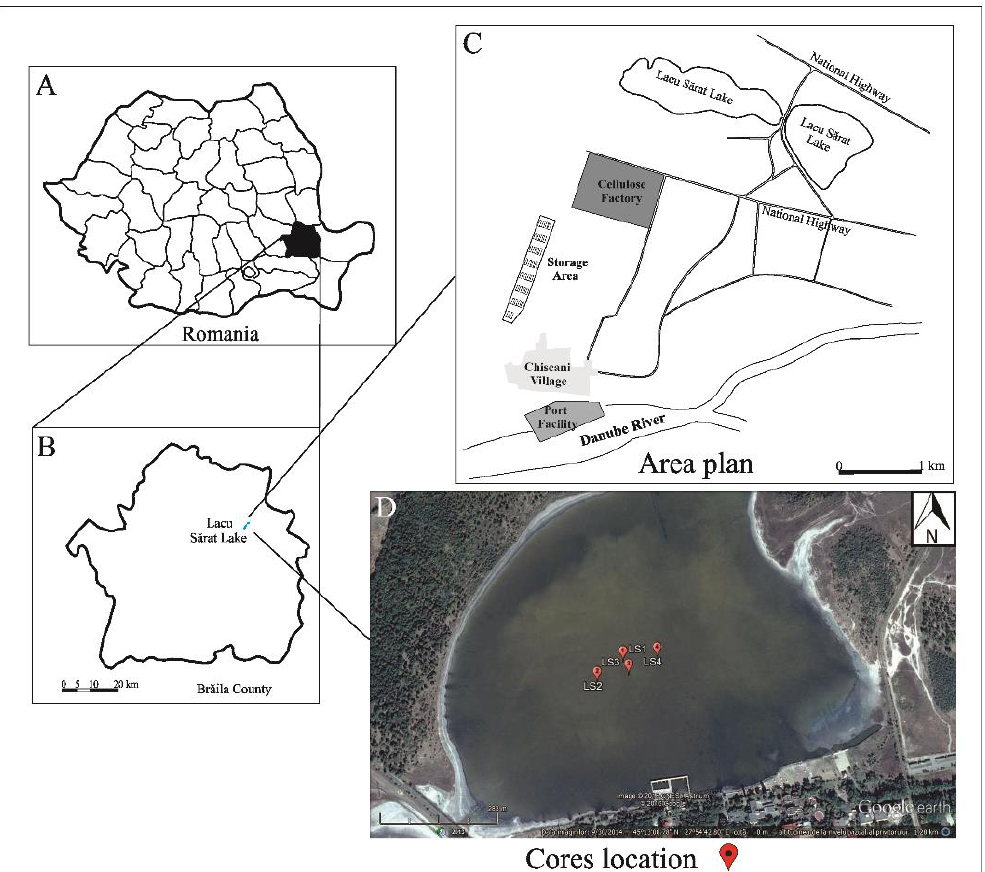
Figure 1. Map of the Lacu Sărat Area (Brăila County, Romania): ( A ) Brăila county location in Romania; ( B ) Lacu Sărat Lake location in Brăila county; ( C ) Simplified plan of Lacu Sărat Lake area; ( D ) Sediment cores location (Google Earth Map).